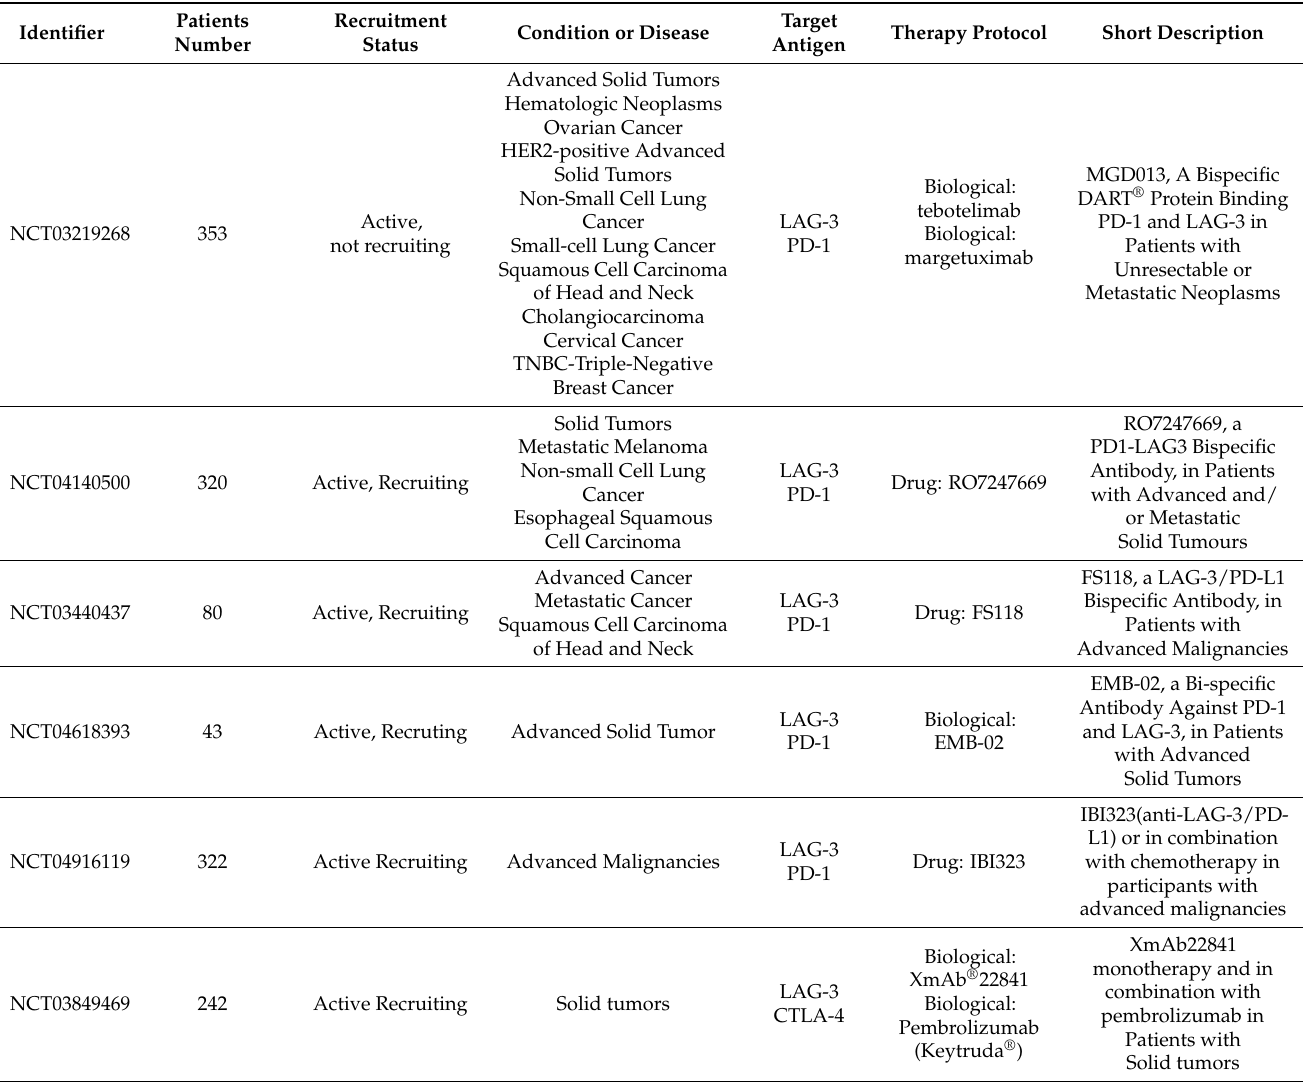
Table 2. Examples of Clinical Trials involving Anti-LAG-3